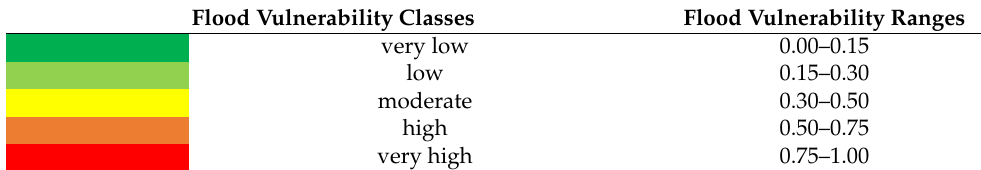
Table 1. Qualitative range of flood vulnerabilities